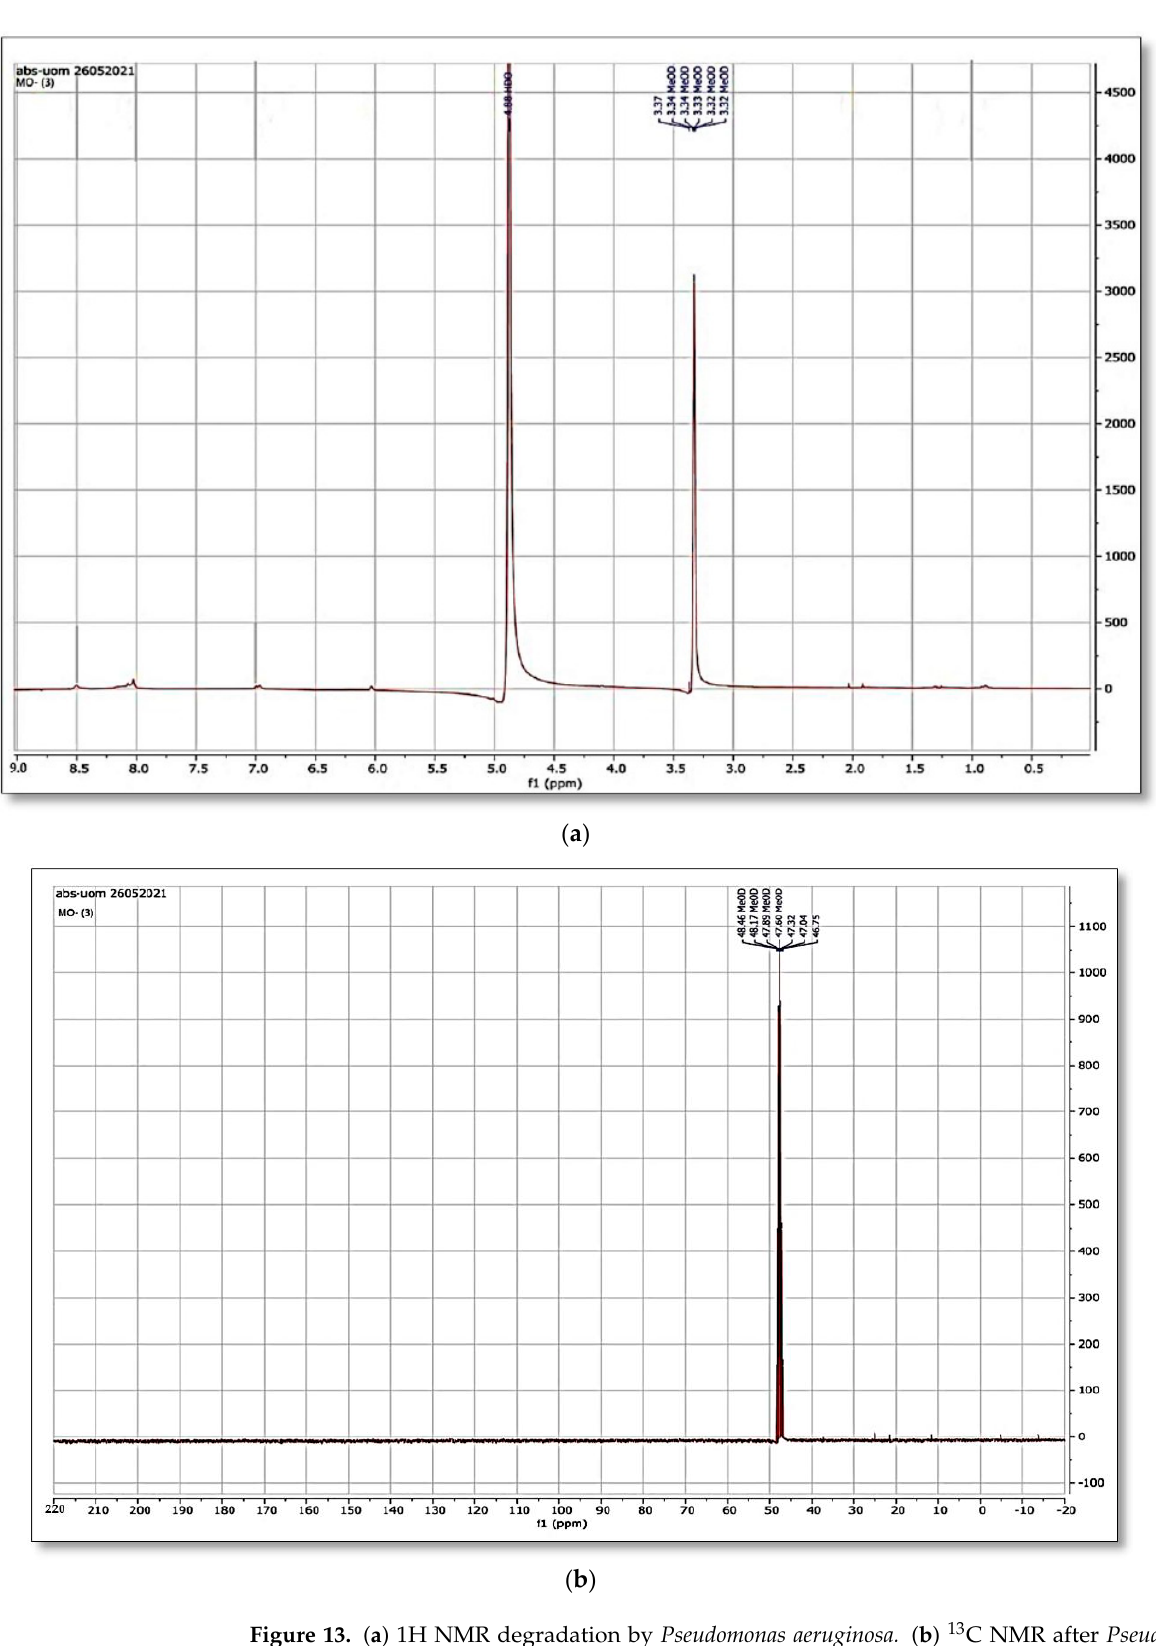
Figure 12. ( a ) Original dye methyl orange 1 H NMR. ( b ) 13 C NMR spectroscopy of the original dye, methyl orange.